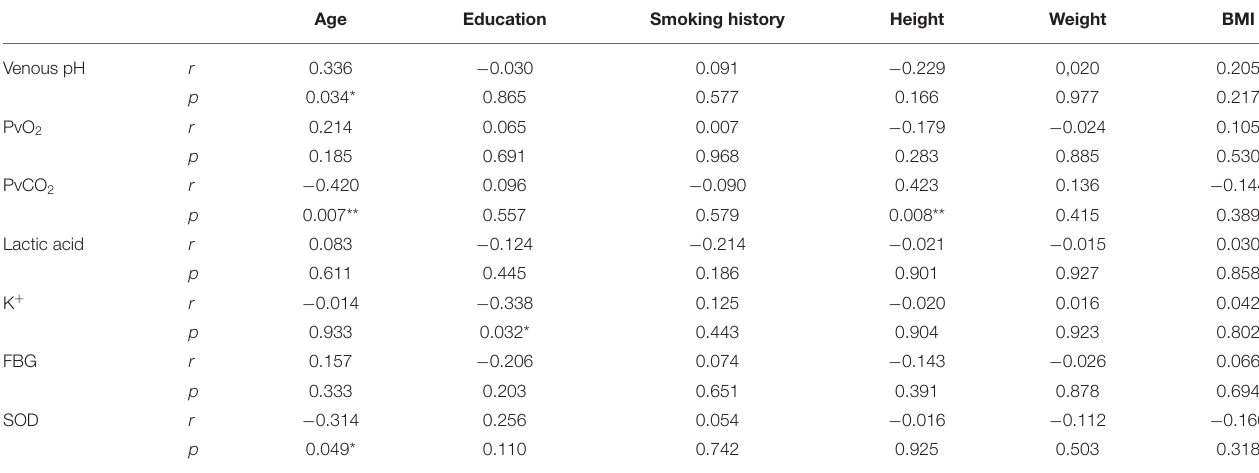
TABLE 4 | Correlation analysis between the general situation and the effect indicators in the control group. Age Education Smoking history Height Weight